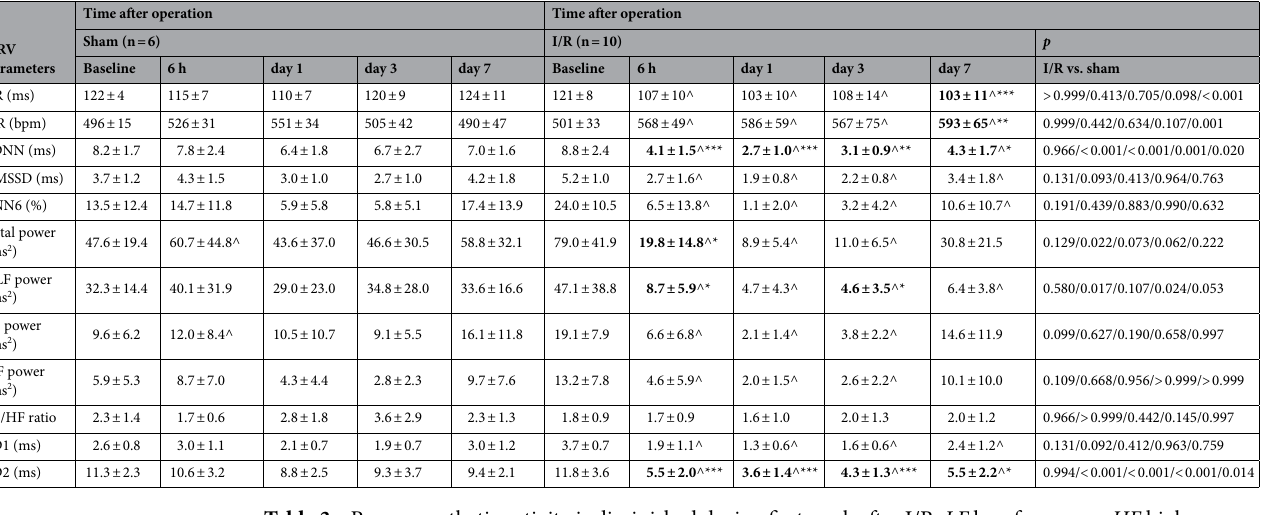
Table 3. Parasympathetic activity is diminished during first week after I/R. LF low-frequency, HF high- frequency, VLF very low-frequency. Data are given as mean ± SD. Statistical significance of differences between I/R and sham control was assessed by two-way ANOVA (Sidak); * p < 0.05; ** p < 0.01; *** p < 0.001. The change of parameters after incident compared to baseline of each group was assessed by two-way ANOVA (Dunnett); ^ p < 0.05. Significant values are in bold.